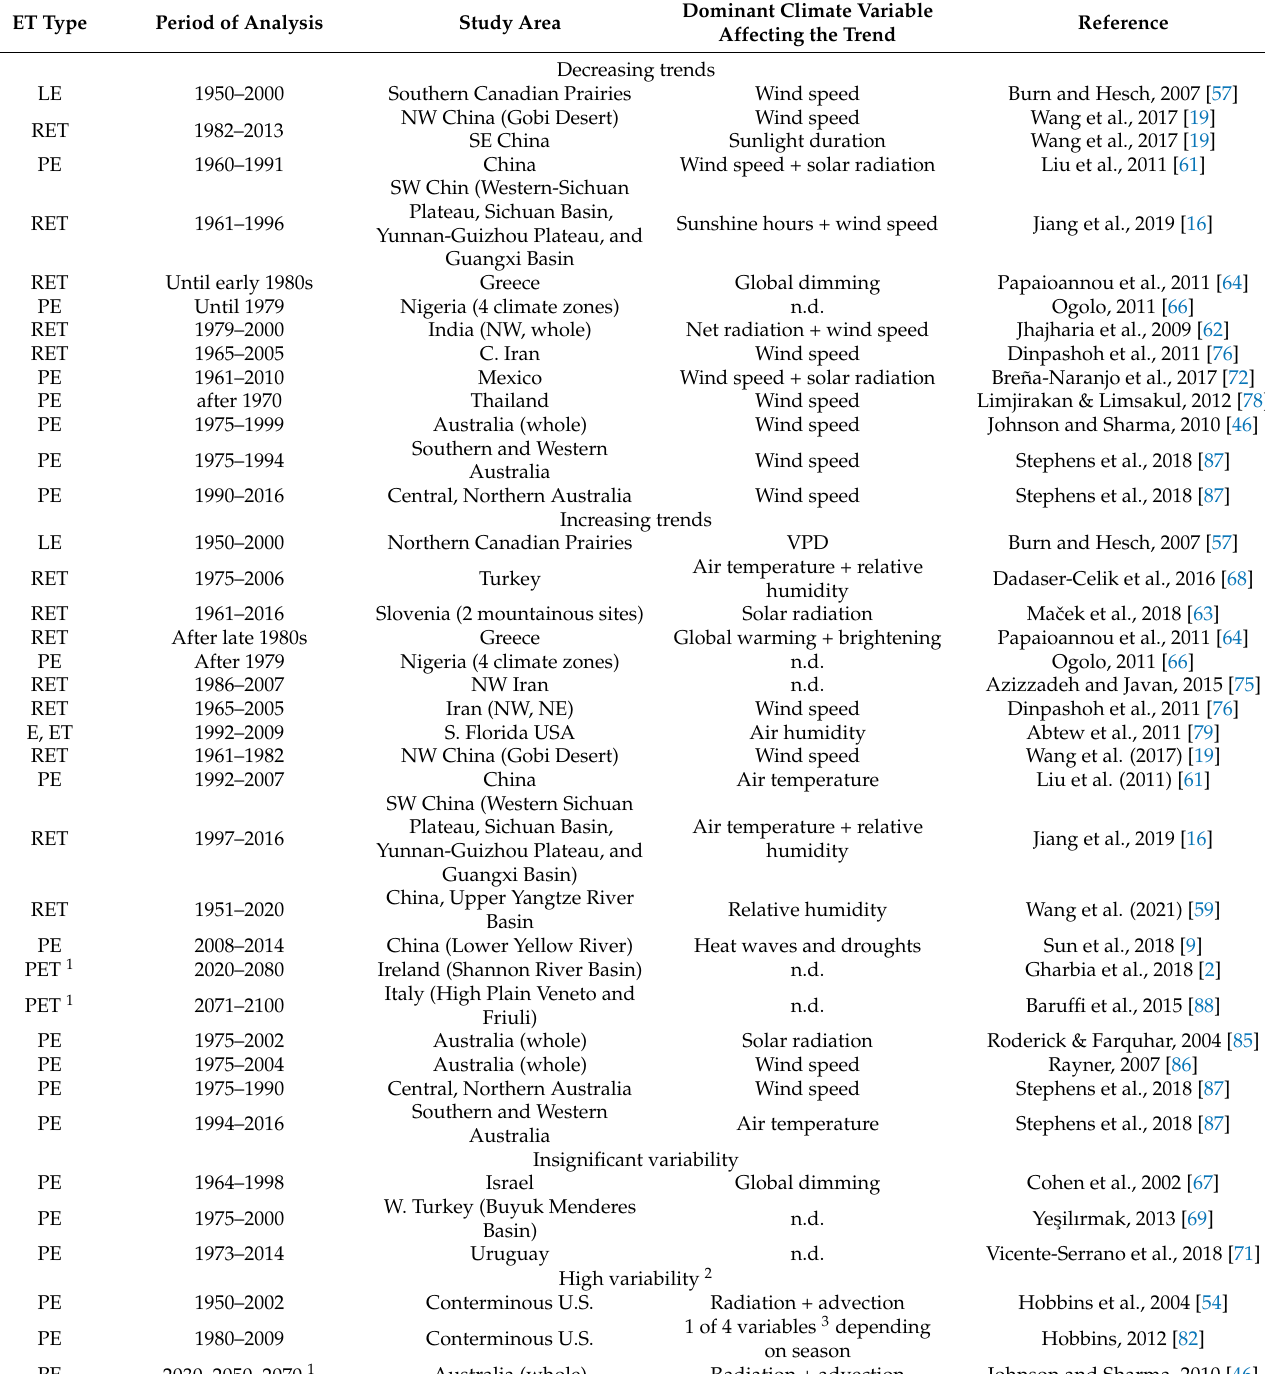
Table 1. Trends in ET (i.e., RET, PE, and LE) categorized as decreasing, increasing, of insignificant variability (no trend), and of high variability (both increasing and decreasing trends—no pattern), and the dominant climate variable affecting ET for each area, as obtained by the latest